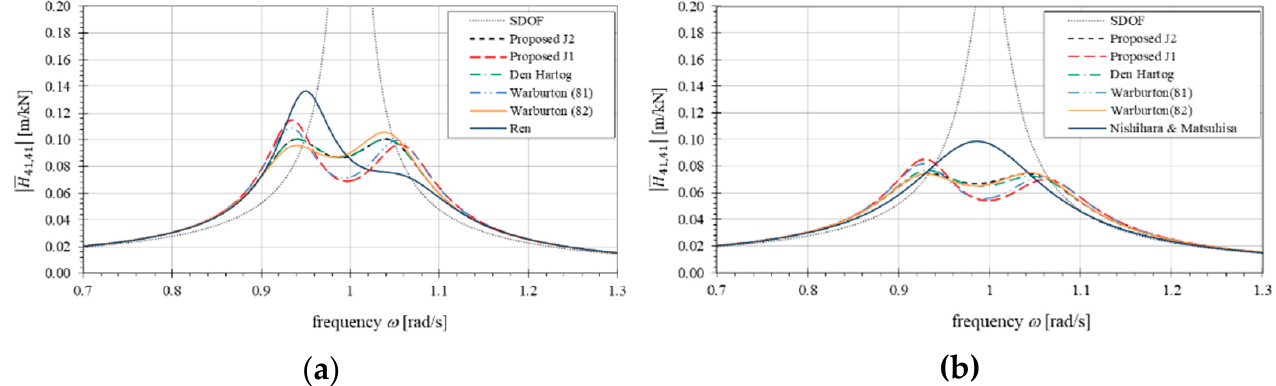
(cid:12) (cid:12) (cid:12) H 41,41 (cid:12) (value corresponds to the FRF | H 1,1 | of a two degree of freedom (TDOF) H (value corresponds to the FRF Figure 9. The module graph for the FRF 41,41 system based on various studies): ( a ) case ζ 1 = 0; ( b ) case ζ 1 = 0.02. In [20], Zuo and Nayfeh conducted a free analysis of the β k , ζ kt parameters, with a constant value of m kt , for 10 and 100 TMDs, with not damping of the primary system ζ 1 = 0 and a µ = 0.05 mass ratio. They applied optimization based on the